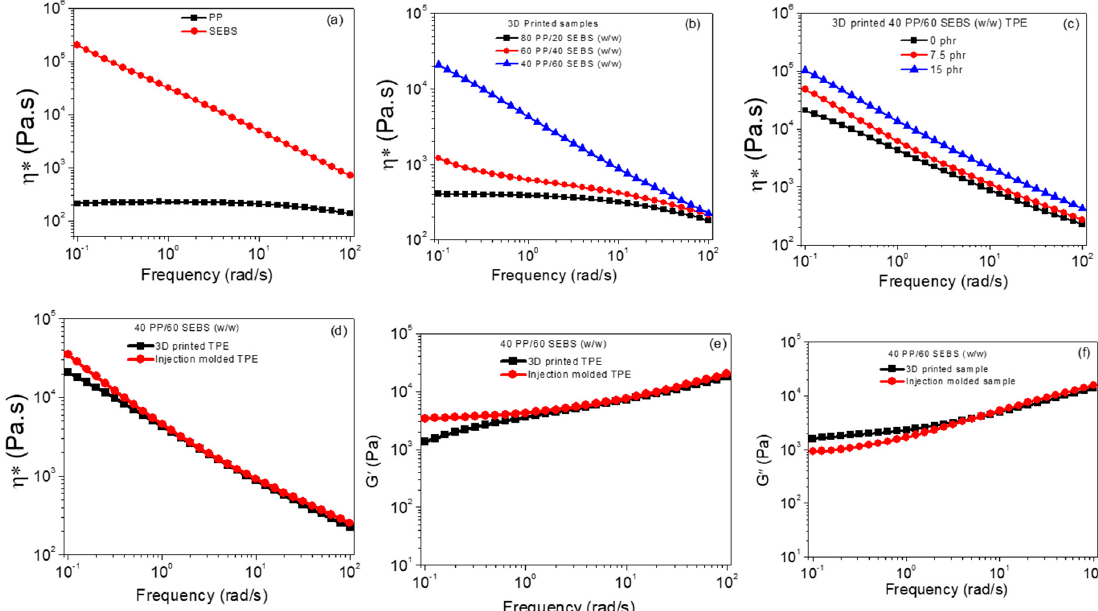
Figure 5. Rheological behavior of 3D printed PP/SEBS blends: ( a ) Complex viscosity ( η *) vs. angular frequency of pristine PP and SEBS, ( b ) complex viscosity ( η *) vs. angular frequency of 3D printed PP/SEBS blends having various blend ratios, ( c ) complex viscosity ( η *) vs. angular frequency of the 3D printed carbon black filled TPE (loading of carbon black was varied from 0 to 15 phr) ( d ) complex viscosity ( η *) vs. angular frequency of the 3D printed TPE vs. injection molded TPE, ( e ) storage modulus (G’) as a function of angular frequency of 3D printed TPE vs. injection molded TPE, and ( f ) loss modulus (G”) as a function of angular frequency of 3D printed vs. injection molded TPE.